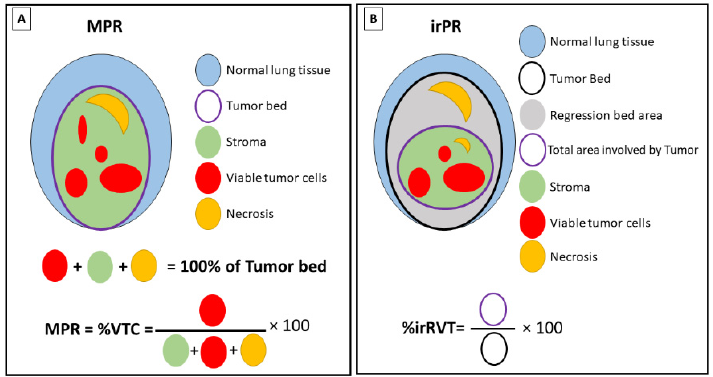
Figure 1. Histologic assessment of major pathologic response and immune-related pathologic com- plete response. ( A ) Schematic representation of the tissue components for the assessment of major pathologic response (MPR) in sample specimen of primary tumor. The tumor bed is constituted by viable tumor cells (VTC), stroma (including inflammatory cells and fibrosis), and necrosis. All the components in the tumor bed area have a sum of 100% ( B ) Schematic representation of the tissue components for the assessment of the immune-related pathologic response (irPR) in sample specimen of primary tumor. The tumor bed contains the regression bed, where immune-related histologic features can be observed, and an inner area involved by tumor that is constituted by viable tumor cells, stroma (including inflammatory cells and fibrosis), and necrosis. The percentage of residual viable tumor (irRVT) is assessed by dividing the total surface area of RVT (circled in purple) by the total tumor bed area (circled in black) × 100.